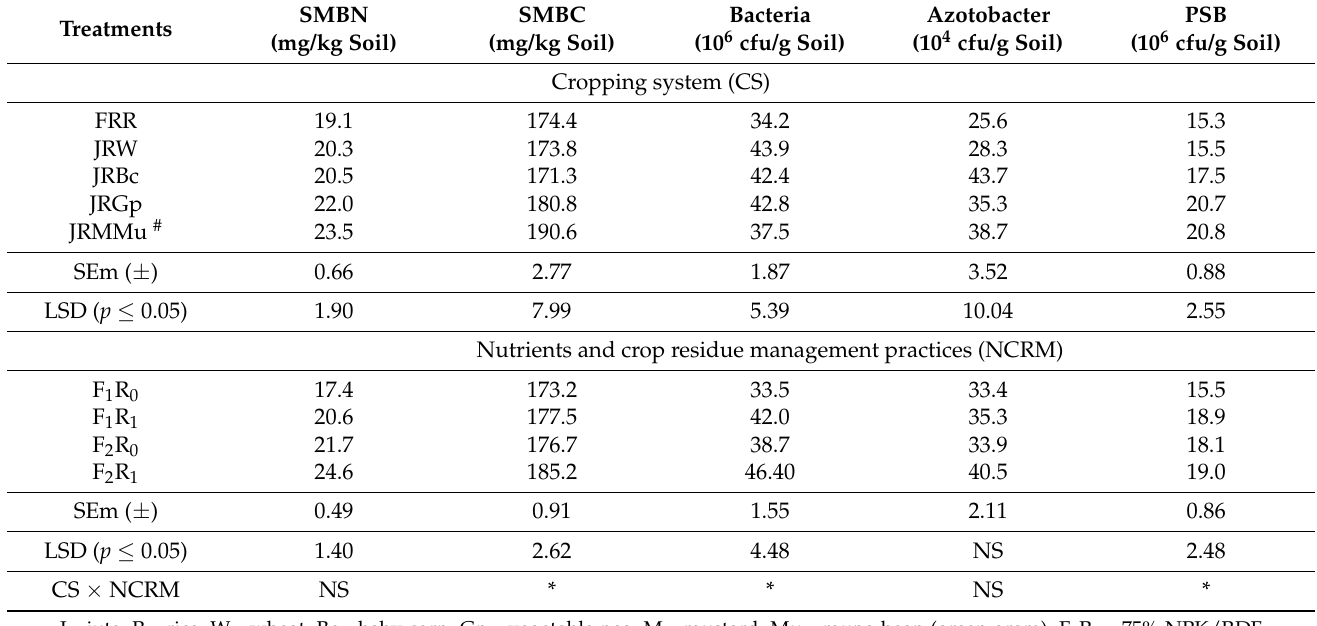
Table 3. Soil microbial properties influenced by different cropping systems and nutrient and crop residue management practices.